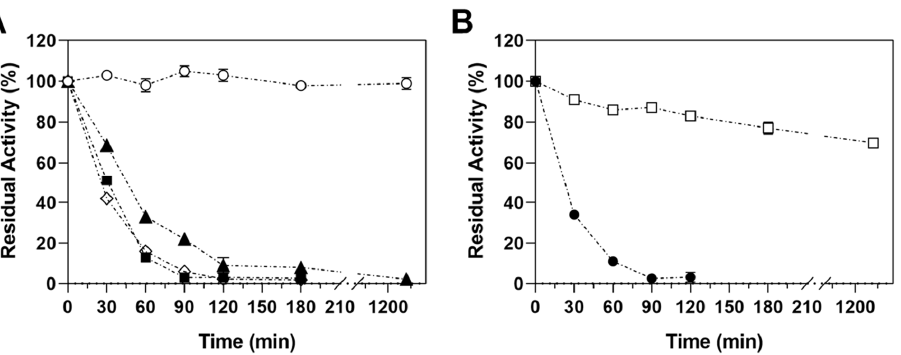
Figure 3. Immobilization of MpXyn10 on different supports. ( A ) Immobilization courses of MpXyn10 on amino-activated supports and ( B ) aldehyde-activated supports. Key: Control ( ○ ), PEI-agarose ( ▲ ), MANAE-agarose ( ■ ), Purolite ( ◊ ), GLUT-agarose ( ● ), and Glyoxyl-agarose ( □ ). The error bars represent the standard error of the mean.